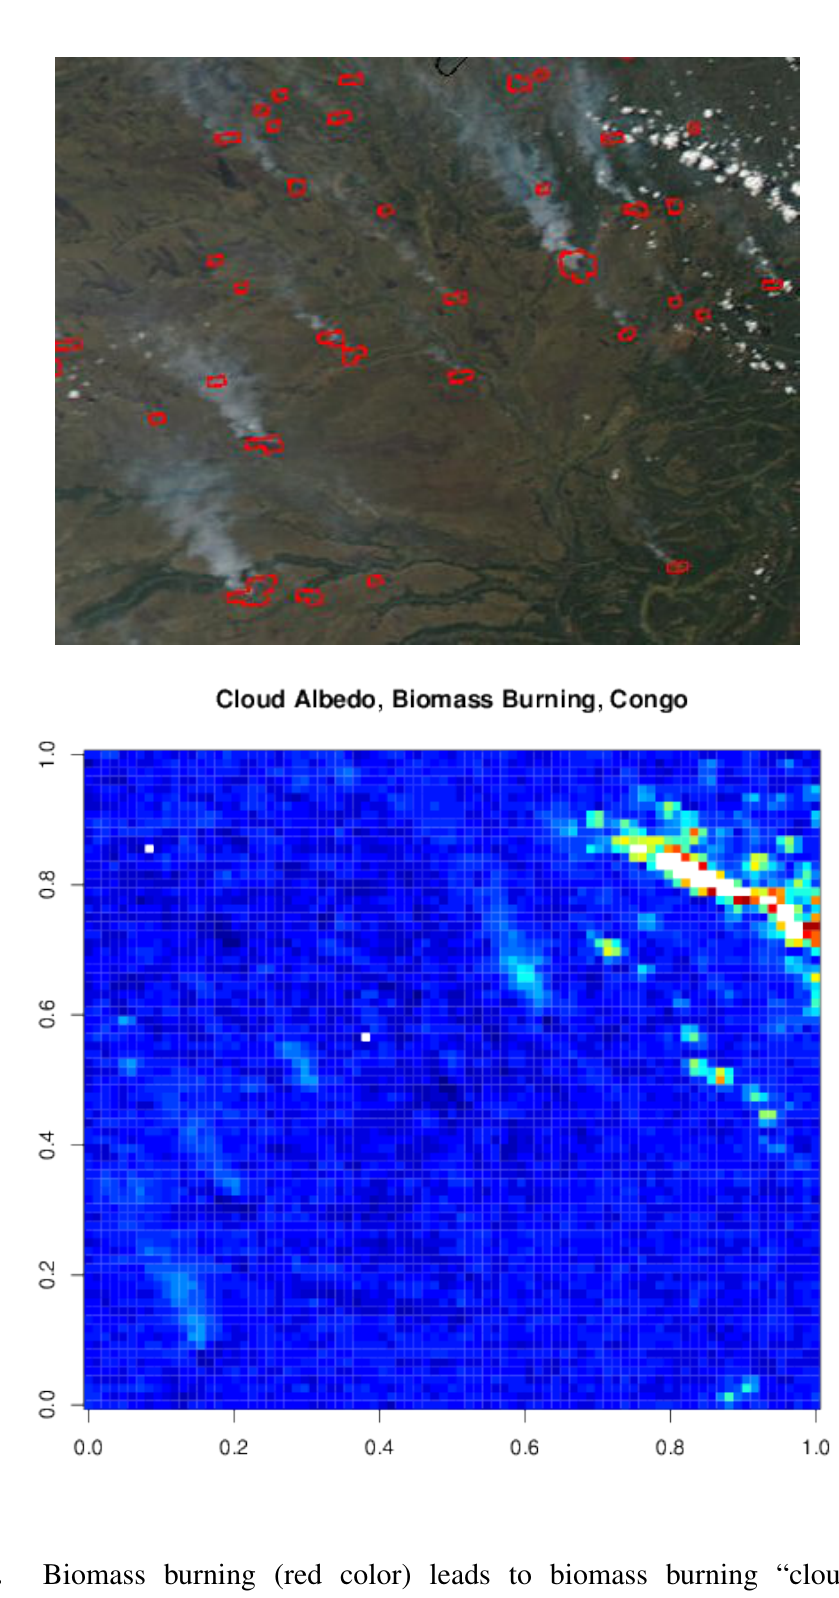
Figure 3. Biomass burning (red color) leads to biomass burning “clouds” in the MODIS [19,26] fire monitoring image, 13 June 2003, 12:30 (top). The thick fire clouds with large geographical coverage are also apparent as increased CAL values (pale blue) in the CAL image (same time). However, compared to the desert event images the effect seems to be less pronounced. This item will be discussed later